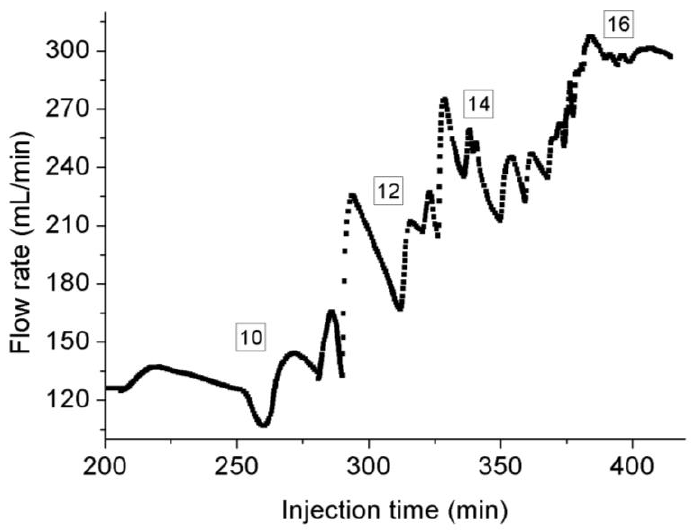
Figure 7. Flow rate development with time when injection pressure is higher than 9 MPa.